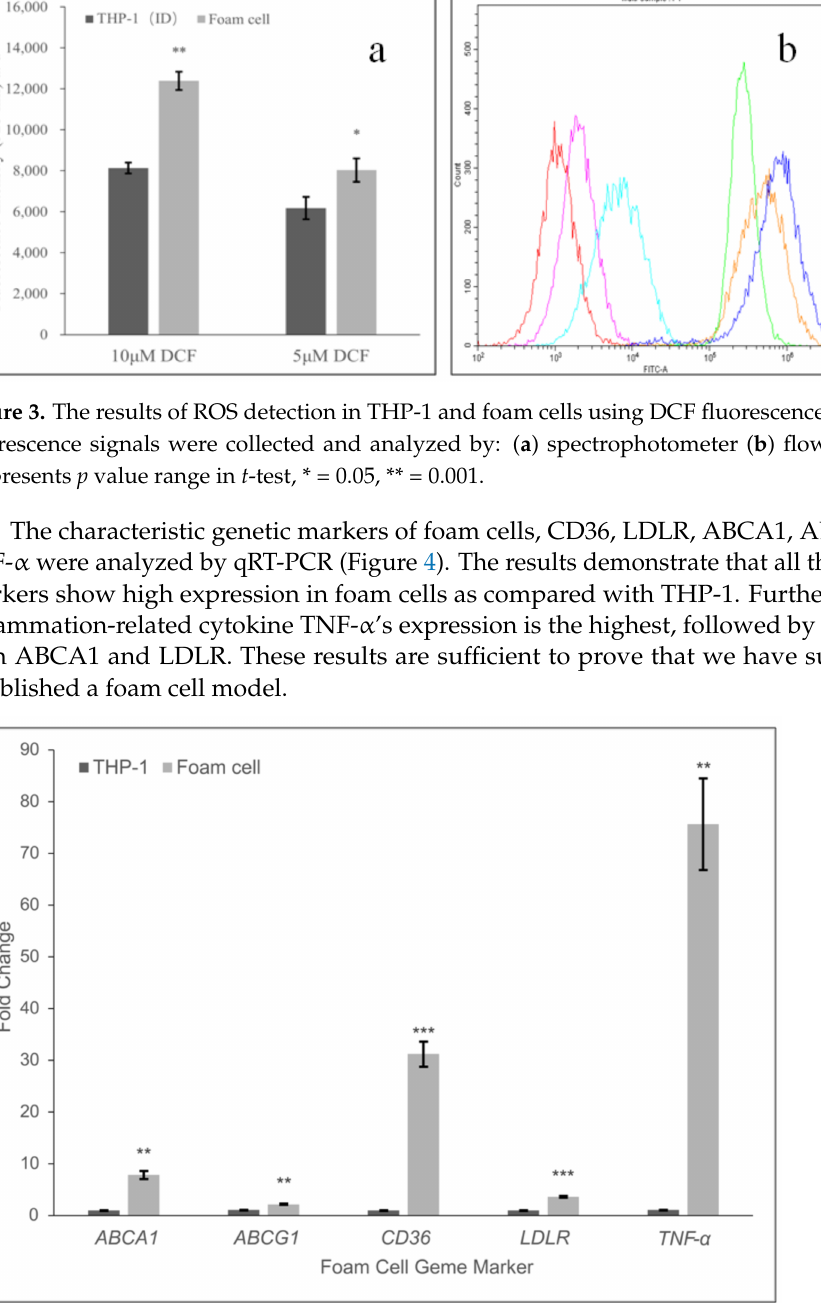
Figure 4. The comparison of genetic markers’ expressions between THP-1 and foam cells by qRT-PCR. * represents p value range in t -test, ** = 0.001, *** =